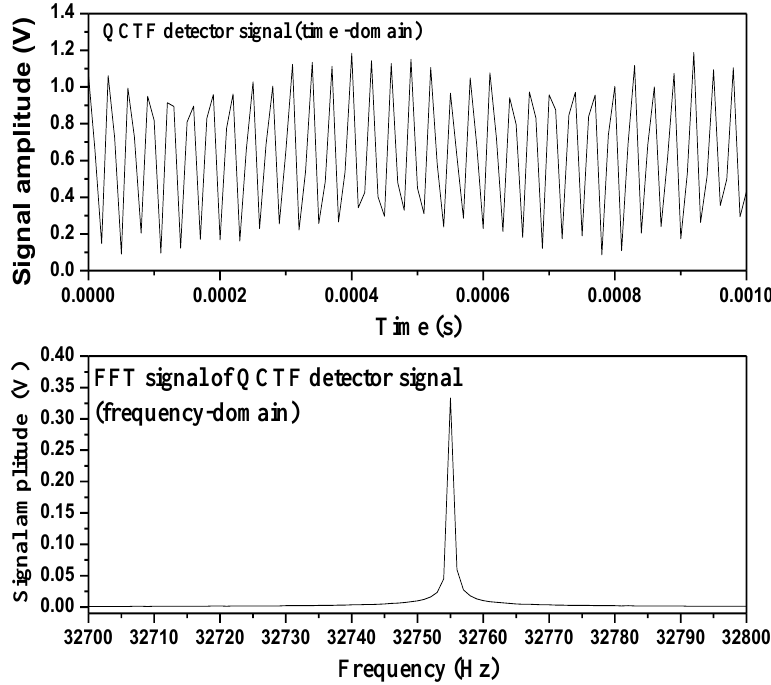
Figure 6. The QCTF signal processing procedure.